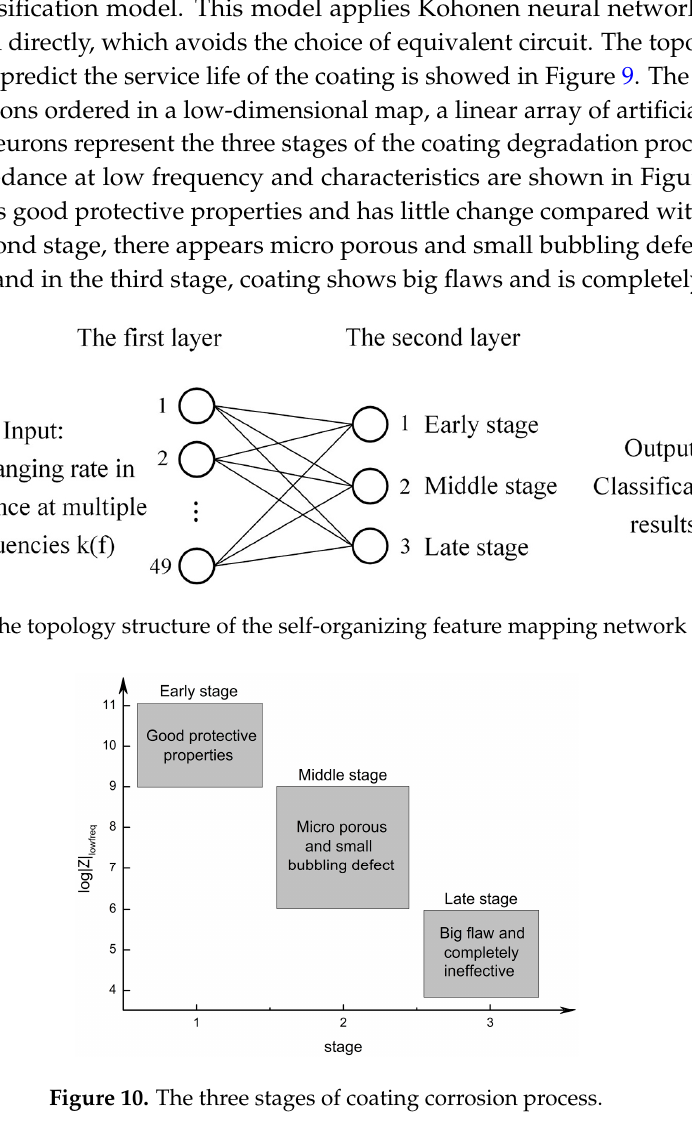
Figure 10. The three stages of coating corrosion process.